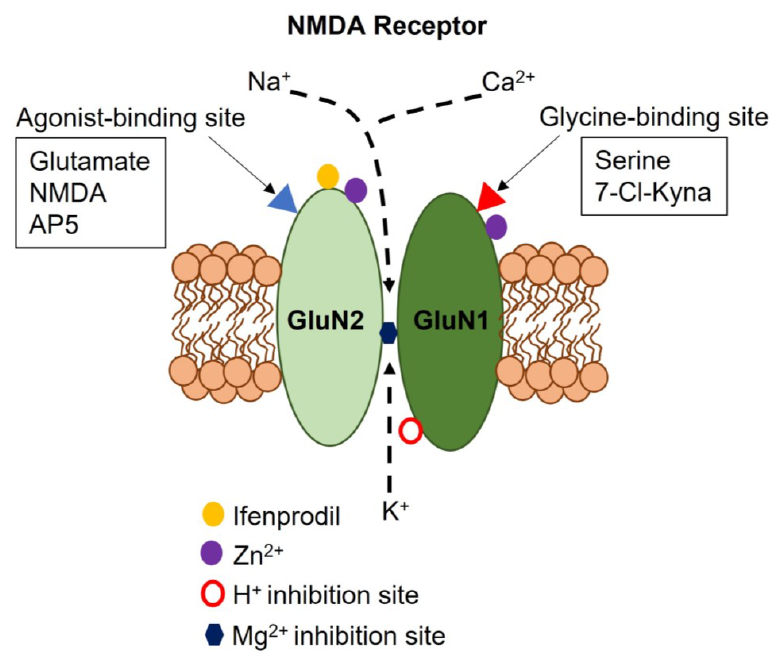
Figure 1. Structure of the neuronal NMDAR. Neuronal NMDARs are heterotetramers comprising two obligatory GluN1 subunits and two GluN2 subunits. The GluN1 subunit contains the agonist- binding site, whereas the GluN2 subunit contains the glycine (or serine) binding site. NMDARs are permeable to intracellular K + (outward direction) and extracellular Na + and Ca 2+ (inward direction). The NMDAR channel pore contains a Mg 2+ binding site that must be relieved by AMPA receptor- mediated membrane depolarization to enable glutamate-induced NMDAR activation. Extracellular Zn 2+ binds to both GluN1 and GluN2, whereas ifenprodil selectively binds to GluN2B subunits to enhance H + -mediated NMDAR inhibition. The incorporation of GluN3 subunits (not shown) confers slightly different biophysical features to the NMDAR, including a low Mg 2+ -dependent inhibition, a reduced Ca 2+ permeability, and a lower single-channel